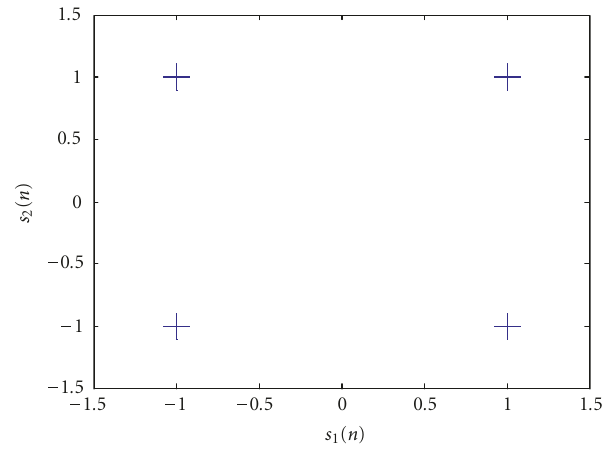
Figure 4: Joint distribution of the sources.